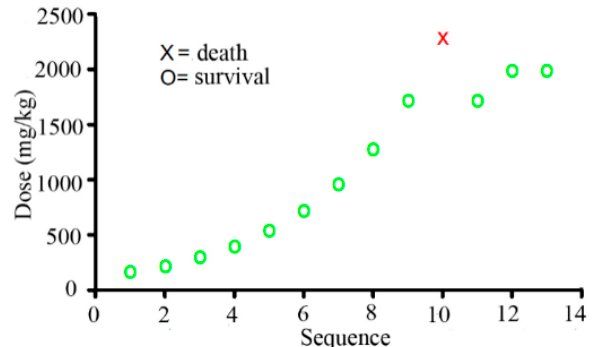
Figure 2. The sequence of the up and down procedure. The surviving animals are marked as green circles and the dead animals as a red cross. The initial dose was 175 mg/kg of the SalB-Rg1 combination.